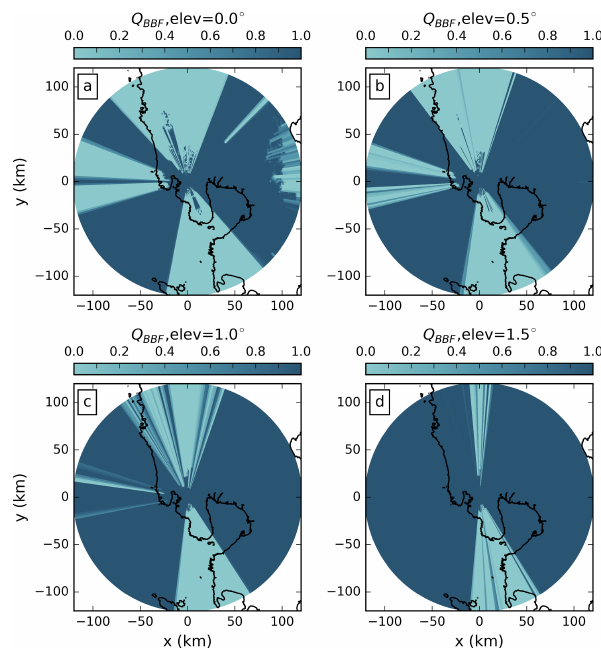
Figure 2. Quality index map of the beam blockage fraction for the Subic radar at (a) 0.0 ◦ , (b) 0.5 ◦ , (c) 1.0 ◦ , and (d) 1.5 ◦ elevation